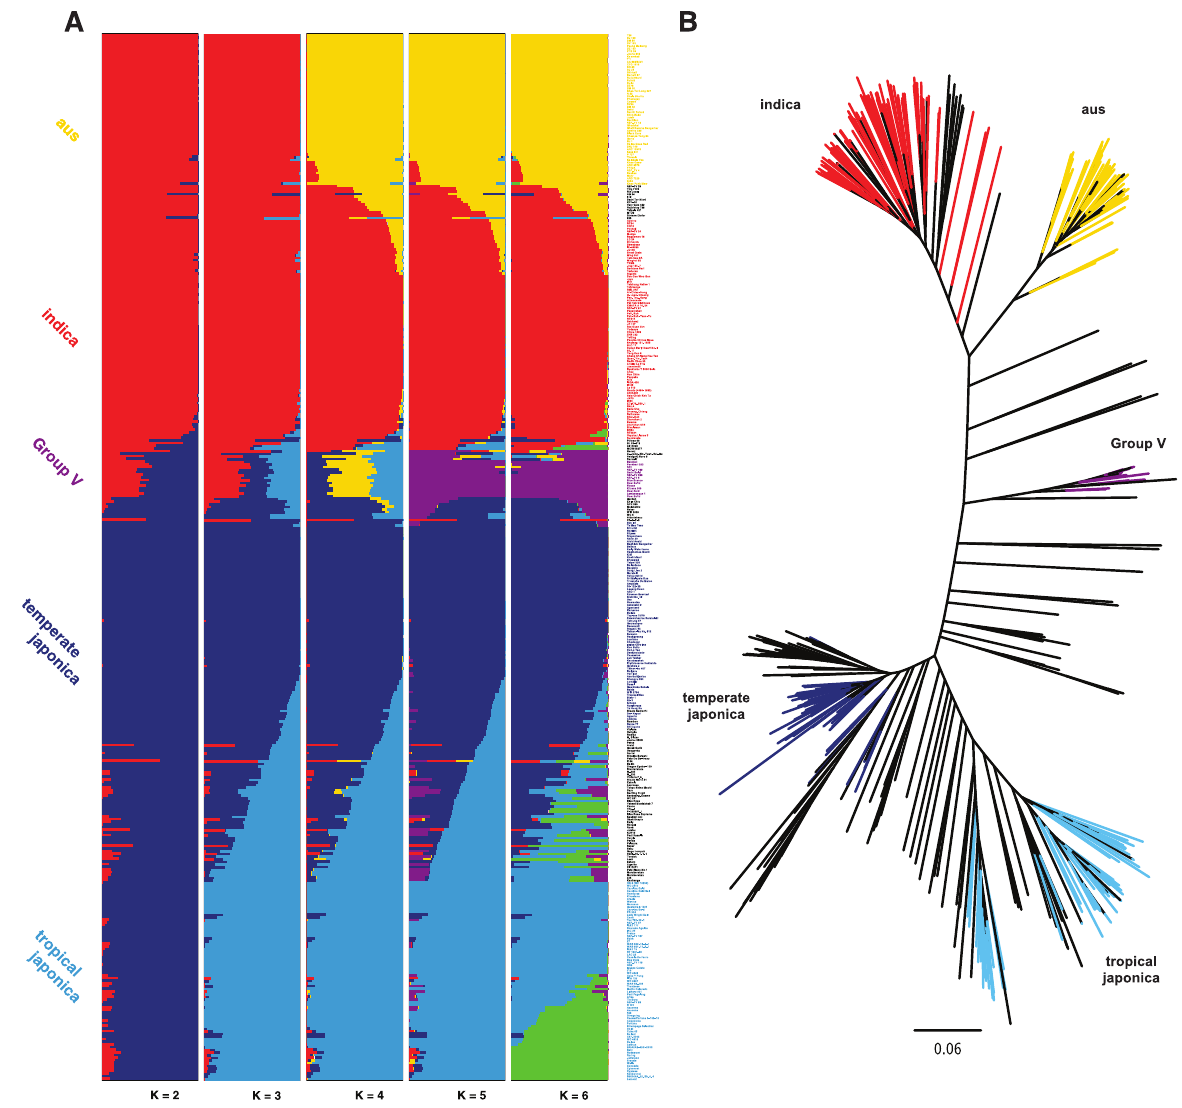
Figure 1. Population structure in O.sativa estimated from the GoldenGate SNP set. (A) Population structure estimate from STRUCTURE output for K=2 to K=6. (B) Phylogenetic tree. The branch tips of the tree are colored according to the subpopulation assignment in (A) when K=5.